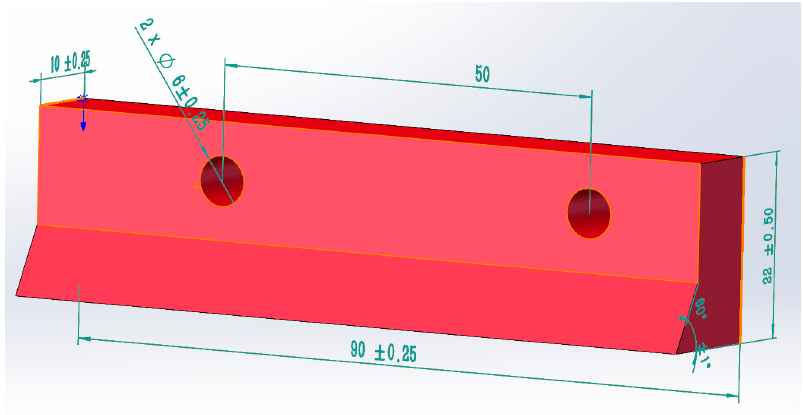
Figure 13. Schematic of the blade.